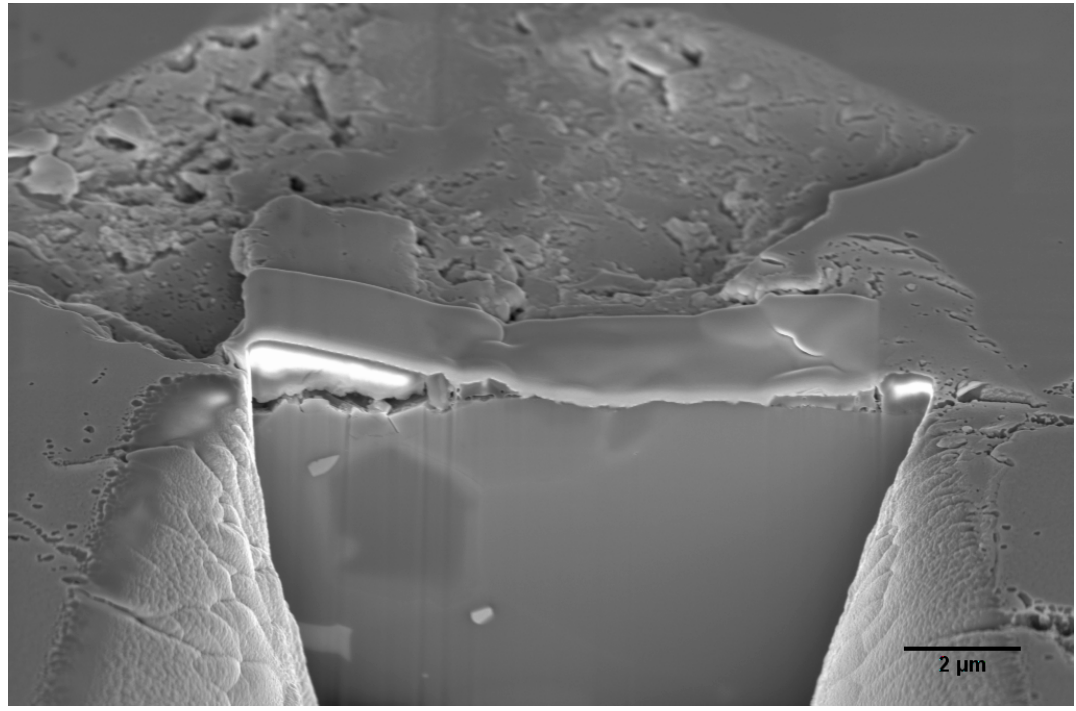
Figure 6. FIB cross section of zone 2 (refer to Figure 4b).